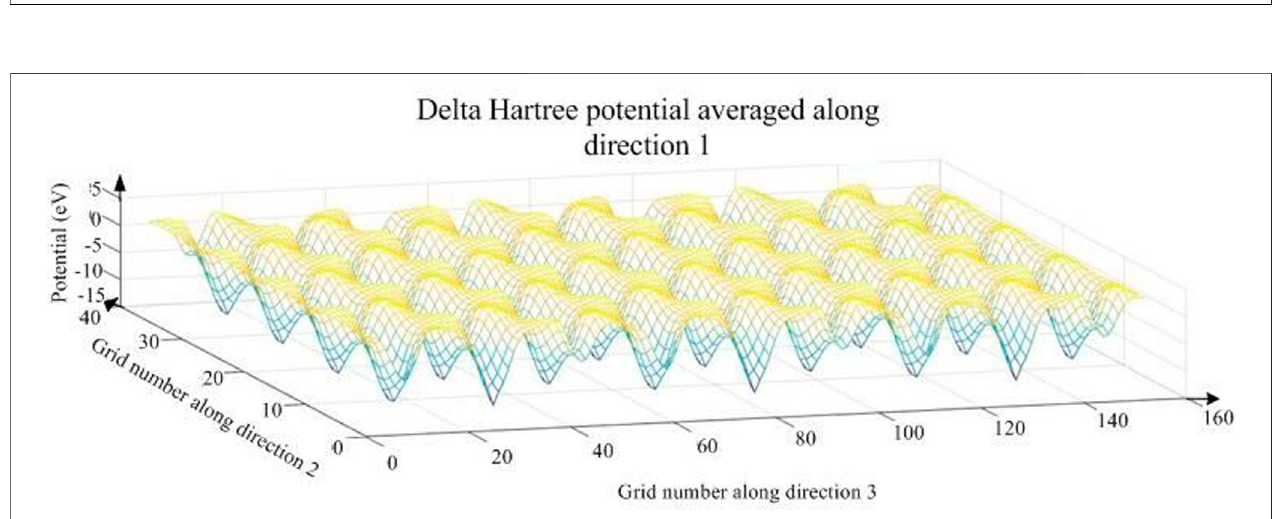
FIGURE 5 | Electron density difference of Li 1.2 − x Na x Mn 0.54 Ni 0.13 Co 0.13 O 2 . (A) The electron cloud ’ s color and coverage of the pristine are shown. (B) When x (cid:2) 0.04 mol,thecolorhasbecomeorangeandtheelectroncloud ’ scoveragehasexpandedobviously,whichmeanitsconductivityisdistinguished. (C) When x (cid:2) 0.10 mol, its color gets brighterand theelectron cloud ’ scoverage gets bigger,whichindicate its conductivity ispromoted extremely. (D) When x (cid:2) 0.11 mol,there isno difference in color between x (cid:2) 0.11 mol and x (cid:2) 0.10 mol and the coverage of the electrons gets bigger continually.